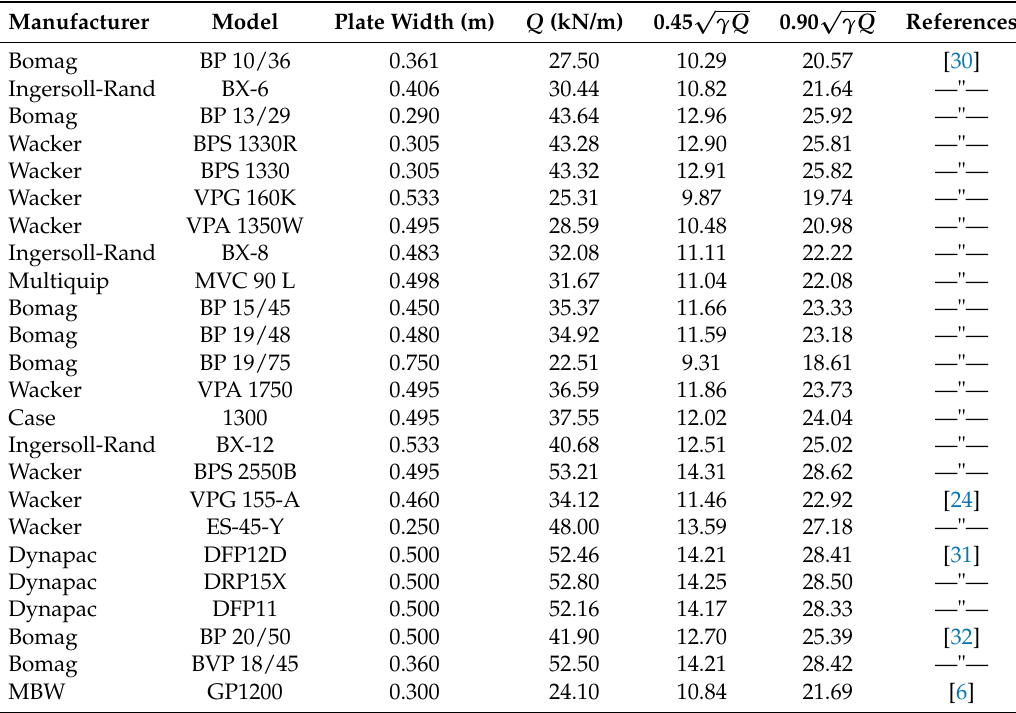
Table 1. Data for vibratory plate soil compactor (light compaction).